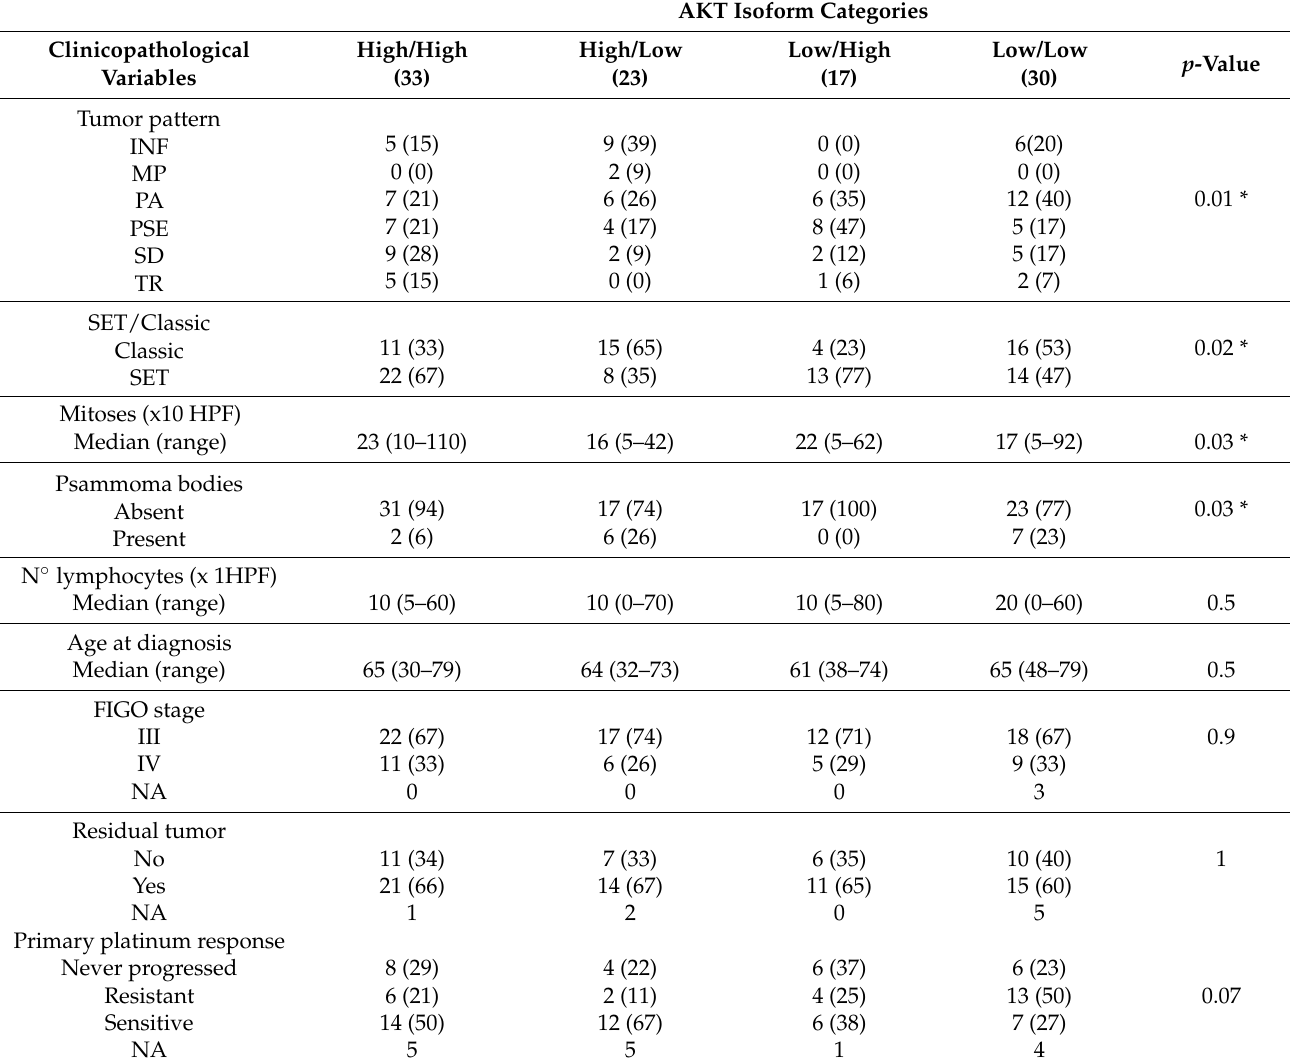
Table 3. Clinicopathological features and their associations with AKT isoform